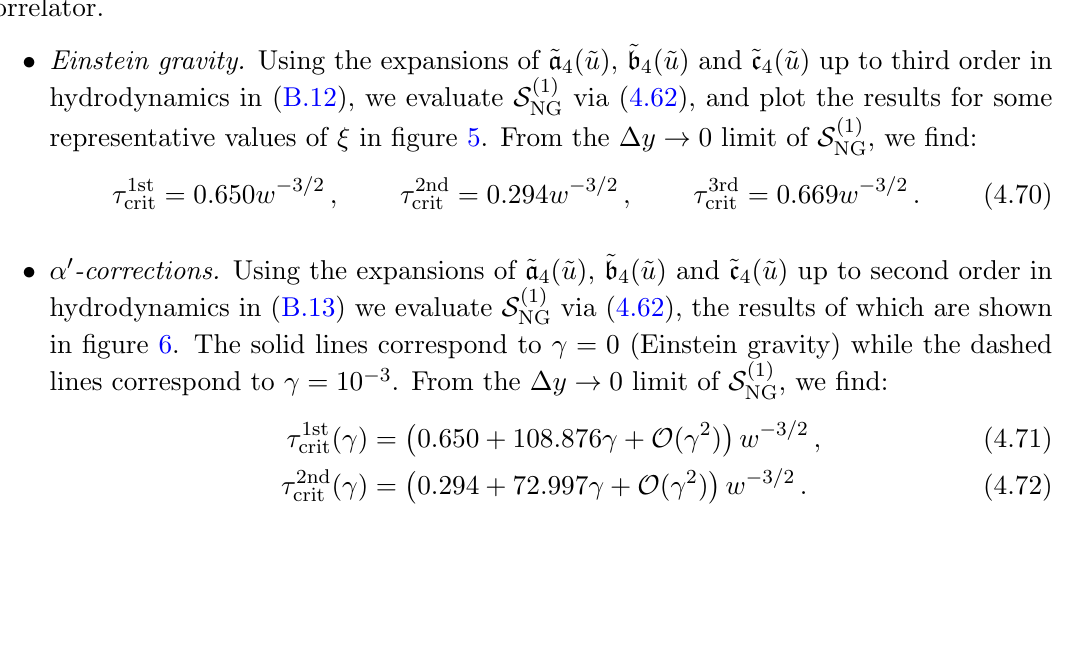
p (cid:17) S (1) (cid:28) 4 = 3 =w 4 ‘ (cid:21) (cid:1) x 3 for various values of (cid:24) = (cid:28) (cid:0) 1 3 0 NG NG (0) for 1 st , 2 nd and 3 rd order hydrodynamics, NG